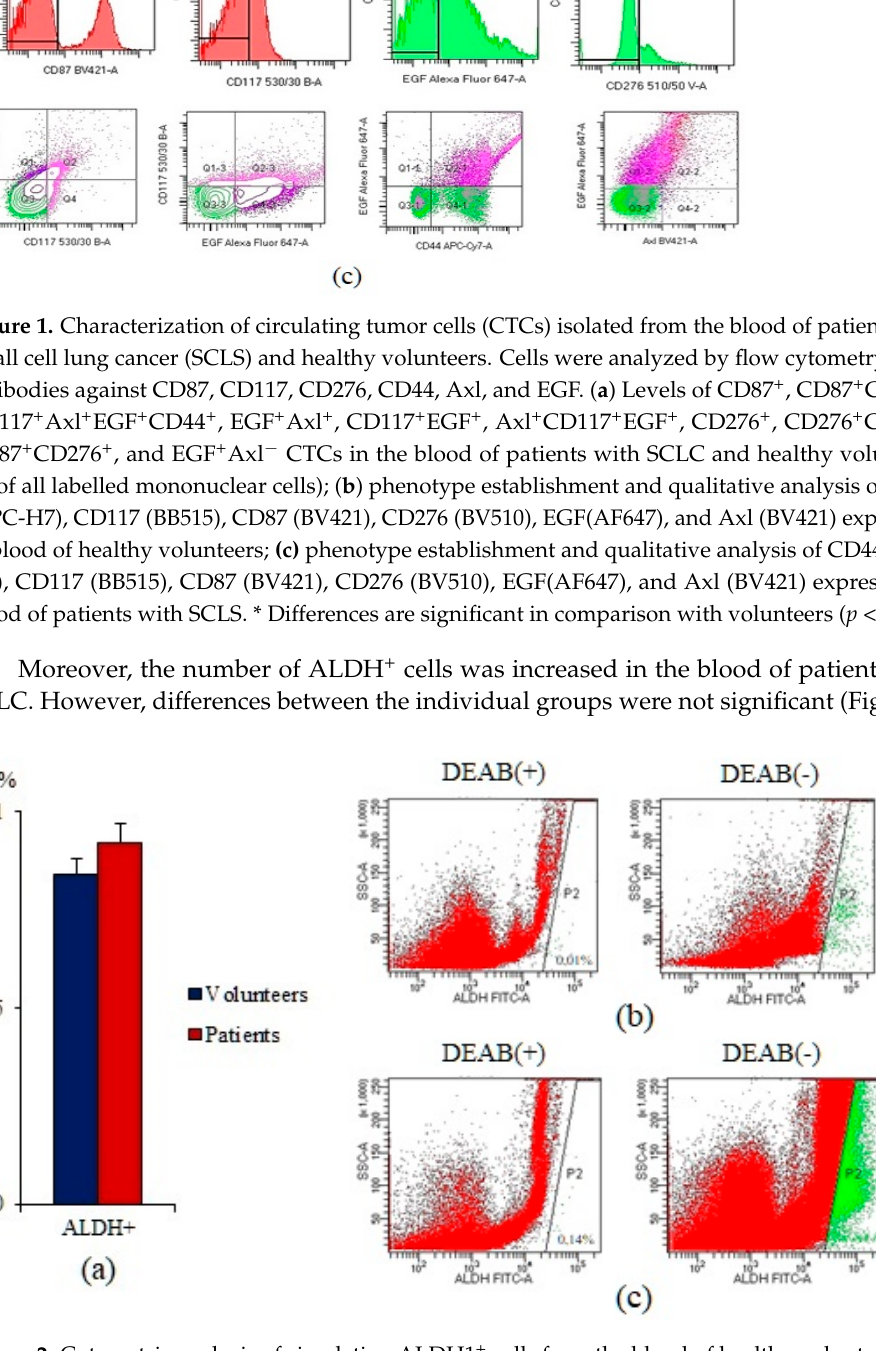
Figure 2. Cytometric analysis of circulating ALDH1 + cells from the blood of healthy volunteers and SCLC patients. ( a ) Level of circulating ALDH1 + cells in the blood of healthy volunteers and SCLC patients; ( b ) Aldefluor FACS analysis of circulating ALDH1 + cells in the blood of healthy volunteers; ( c ) Aldefluor FACS analysis of circulating ALDH1 + cells in the blood of the SCLC